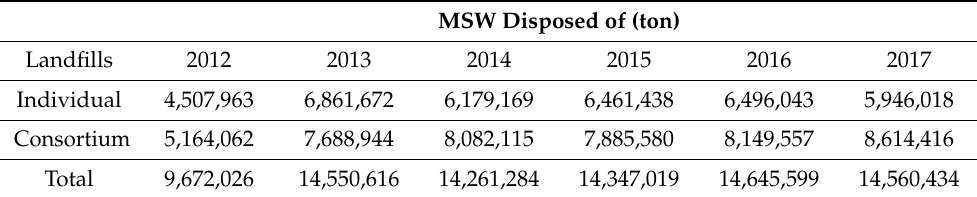
Table 2. MSW disposed of in individual and consortium landfills in S ã o Paulo state. MSW Disposed of